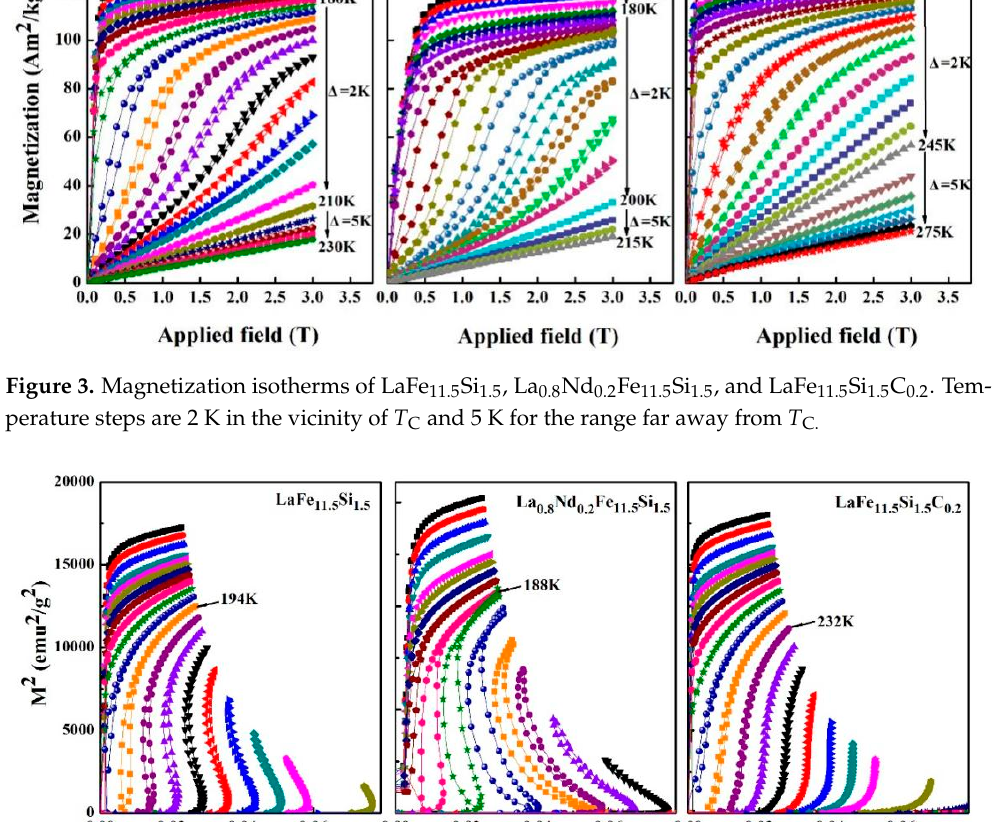
Table 1. The main magnetic properties of LaFe 11.5 Si 1.5 , La 0.8 Nd 0.2 Fe 11.5 Si 1.5 , and LaFe 11.5 Si 1.5 C